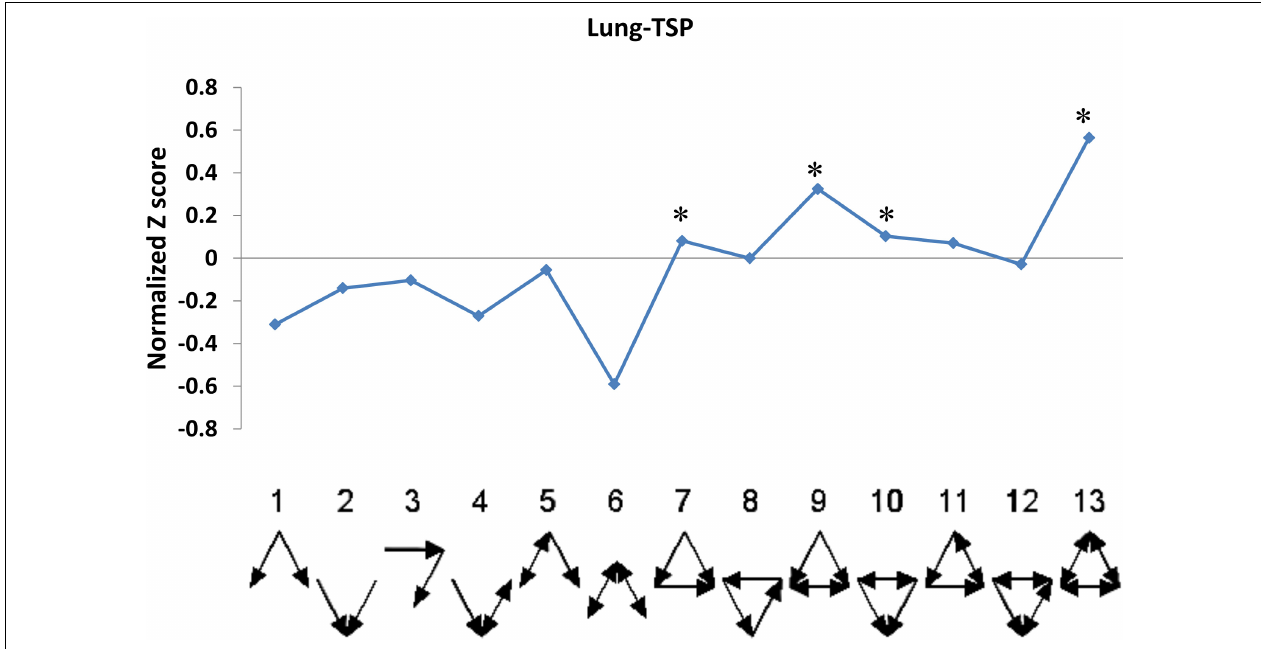
FIGURE 6 | The triad significance profile (TSP) of Tibetan pig lung gene regulatory network. The ordinate in the figure is the normalized Z value, and the abscissa is the 13 motif types. The point marked with “*” is that the frequency of the corresponding motif in the lung tissue gene regulatory network is significantly different from that of random networks ( p < 1E-04). The motifs are FFL (7), Regulated mutual (9), Regulating mutual (10), and Clique (13) in that